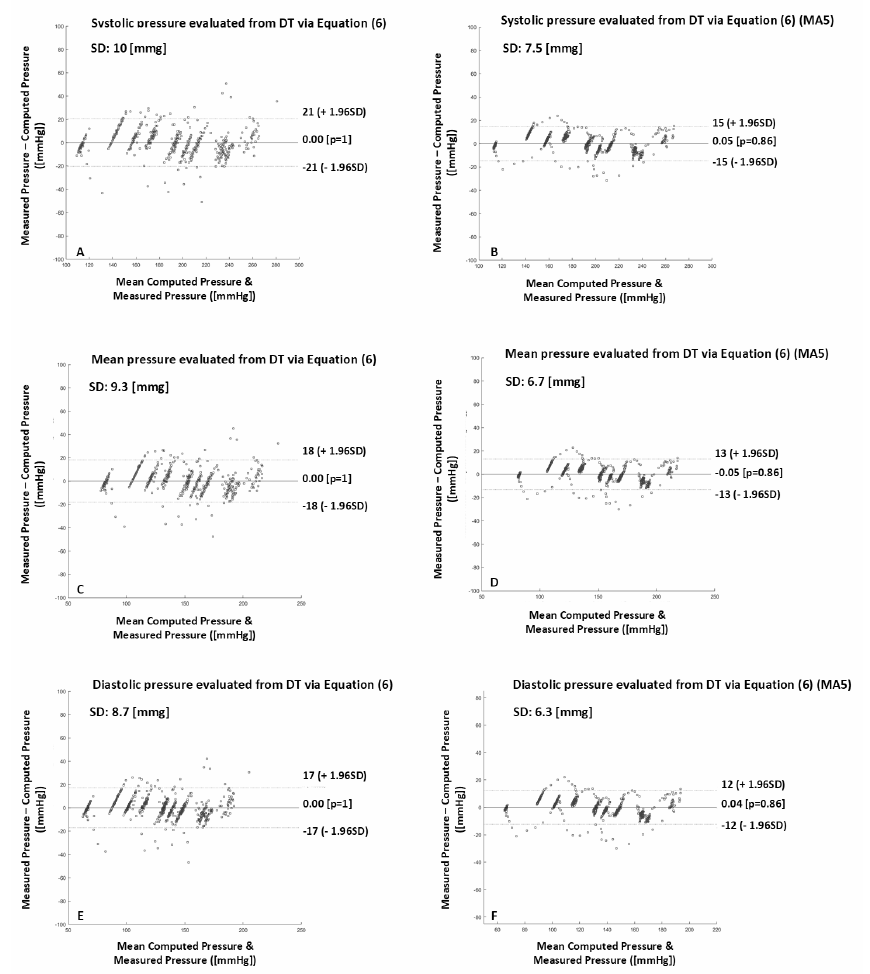
Figure 7. Bland Altman comparisons of BPs measured experimentally vs. those computed via the proposed model (Equation (4)). Comparison of SBP is shown ( A , B ), MAP ( C , D ) and DBP ( E , F ) for not-averaged values ( A , C , E ) and values averaged over five cycles ( B , D , F ). Averaging was made thanks to moving average method (MA5). In all the cases, there is no systematic deviation between the measured and computed BPs while standard deviation decreases when the response is averaged over more